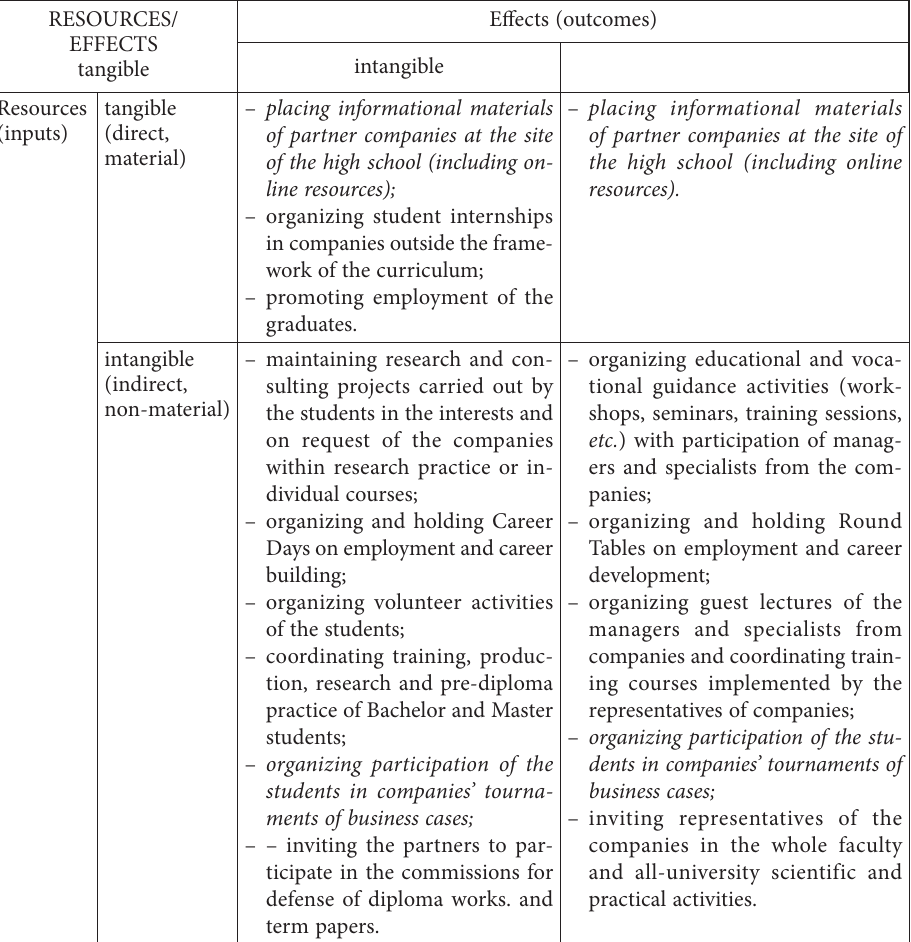
Table 1. A matrix of interaction between universities and partner companies: “tangible/intangible re- sources” and “tangible/intangible effects” (source: created by authors) RESOURCES/